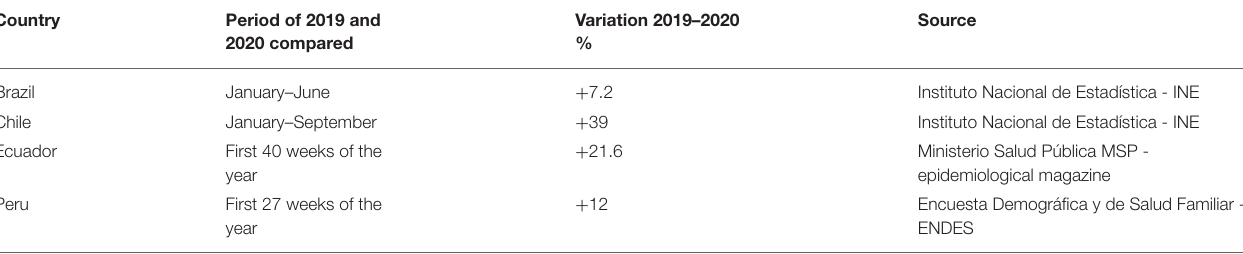
TABLE 10 | Variation in maternal mortality total numbers 2019–2020.